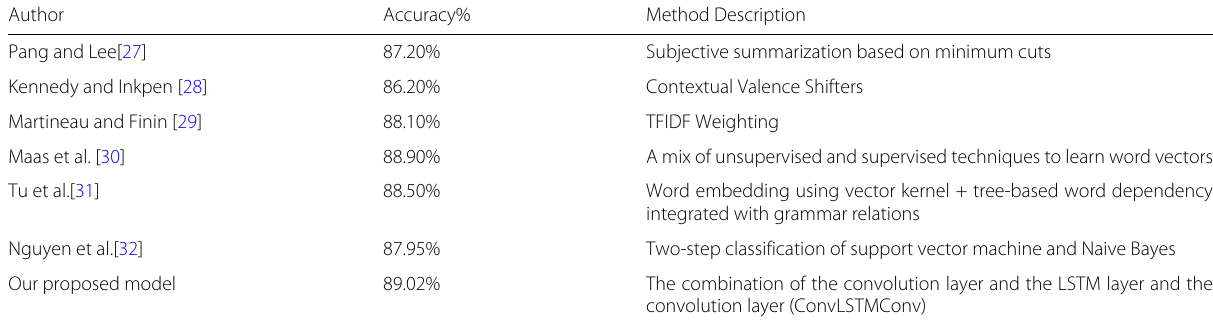
Fig. 5 Accuracy and loss function of our proposed model for sentiment analysis the determination of positive and negative polarity. In real world, there are different situations such as happiness, anger, hatred, sadness and so on which can affect the opin- ion of reviewers. There are many influential factors in this area, some of which are fleeting and affecting opinions Table 5 Comparison among our proposed model and previous